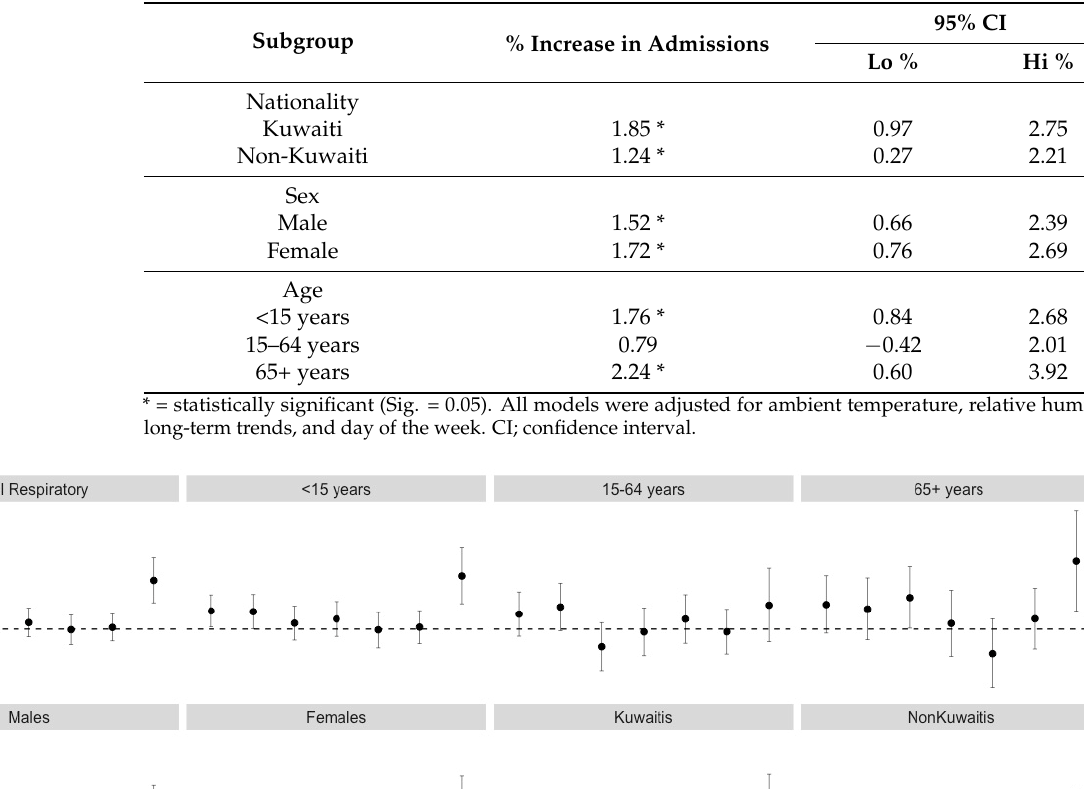
Table 3. Sub-group analysis for the association between average PM 2.5 and respiratory admissions over 0–5 cumulative days lag period using distributed lag models.